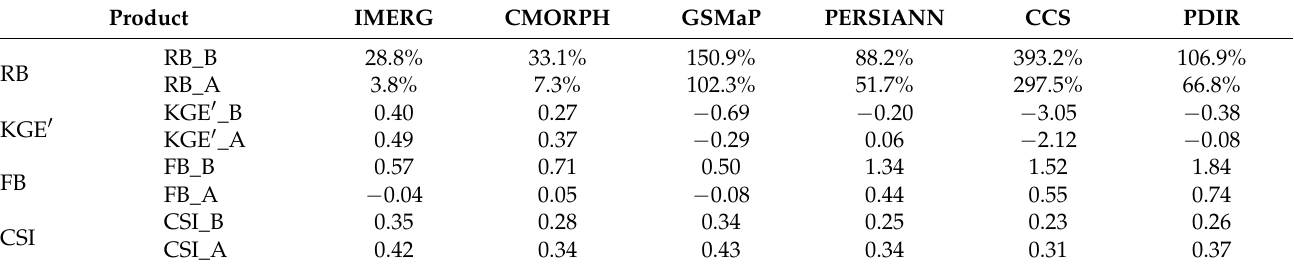
Table 6. The RB, KGE (cid:48) , FB, and CSI of SPPs before bias correction and after bias correction over the whole